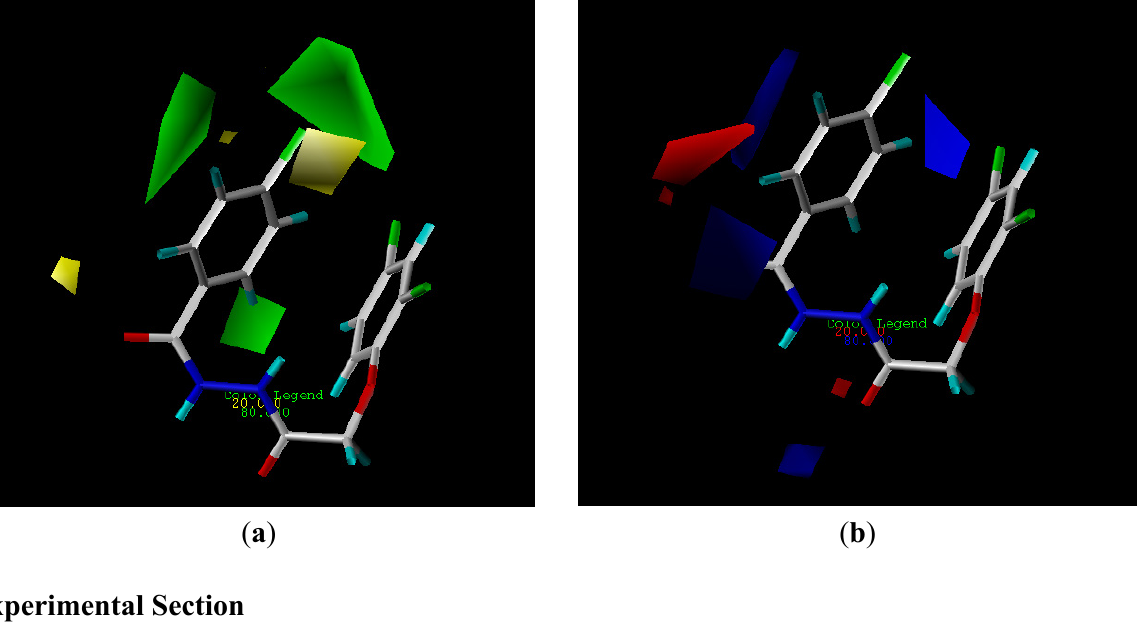
Figure 3. Steric and electrostatic contribution contour maps of